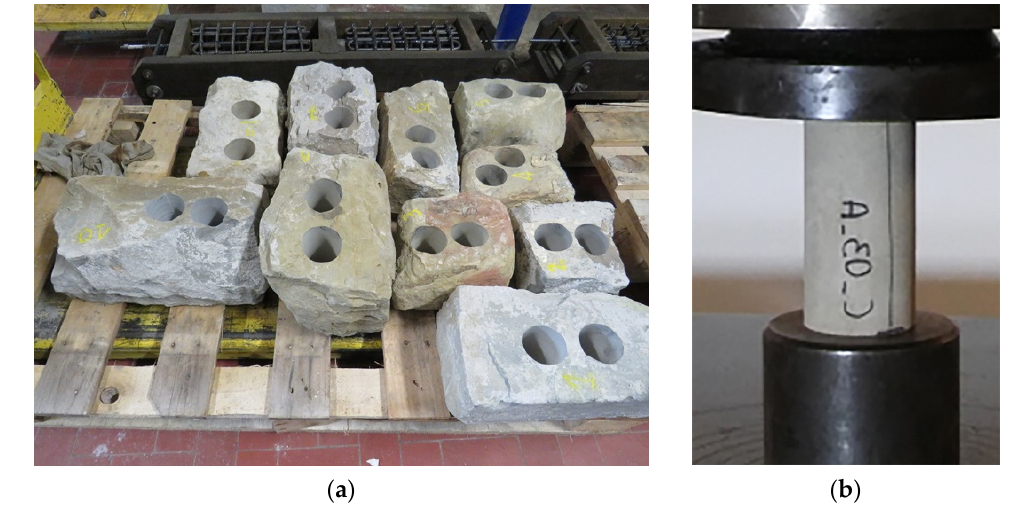
Figure 3. ( a ) Extraction of cores from stones; ( b ) compression test on the stone core sample.